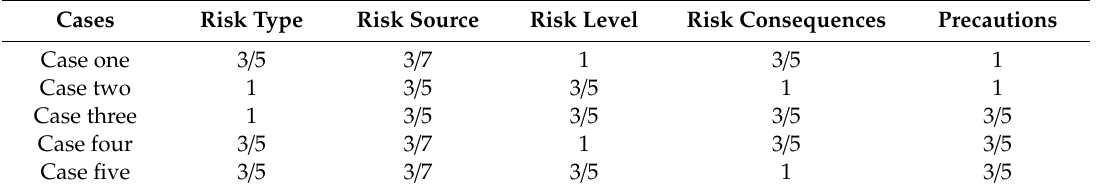
Table 7. Distance-based semantic similarity calculation results.